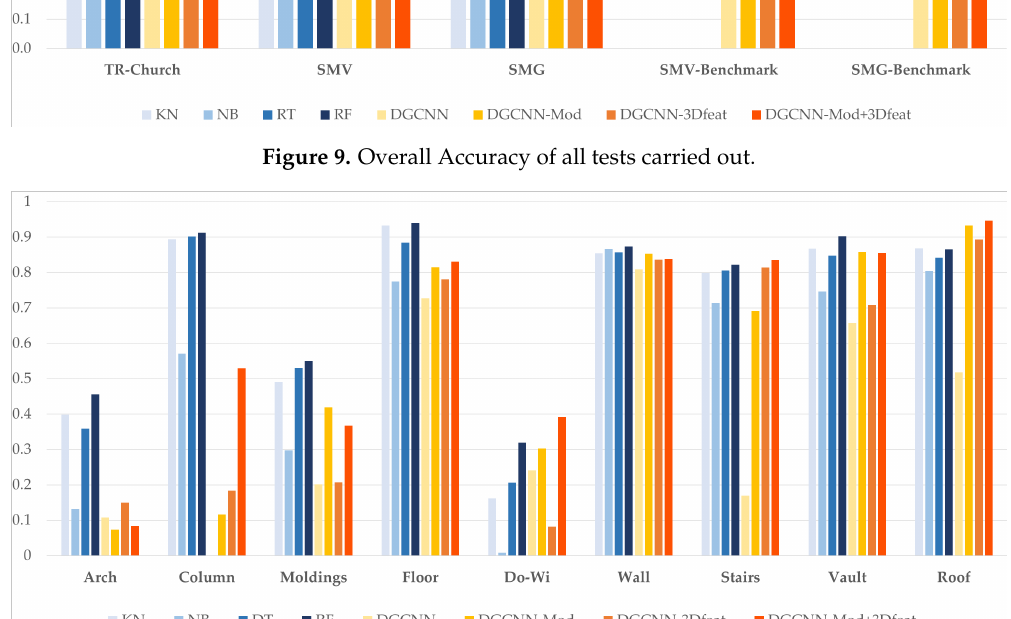
Figure 10. F1-Score of the different classes for the SMV scene with the different